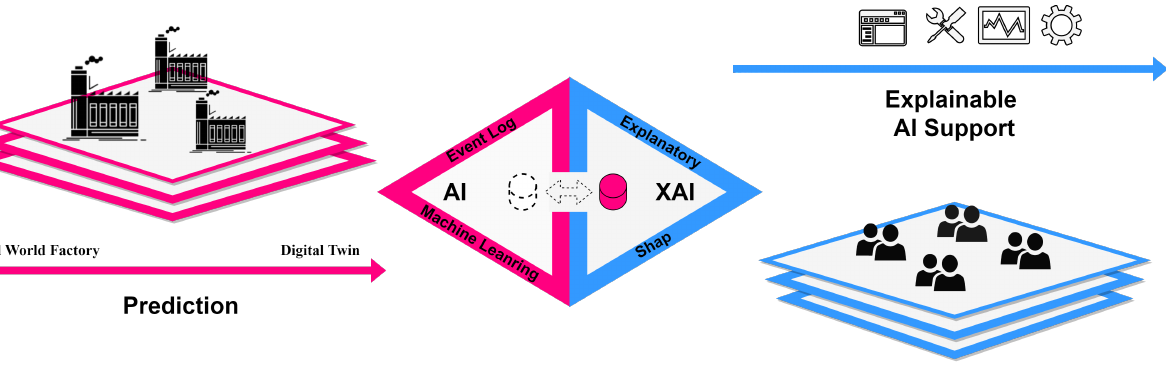
Figure 1. AI cooperation